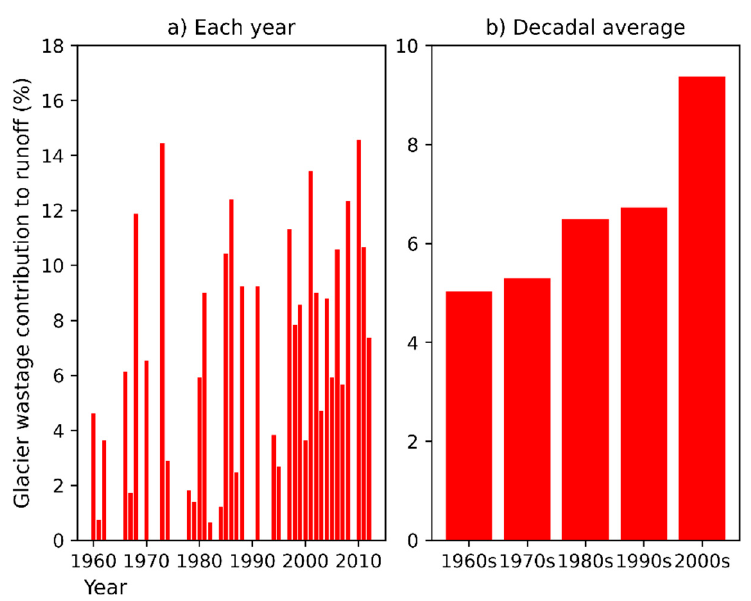
Figure 5. Glacier wasting contribution to the runoff at the river outlet: ( a ) in each year, and ( b ) decadal